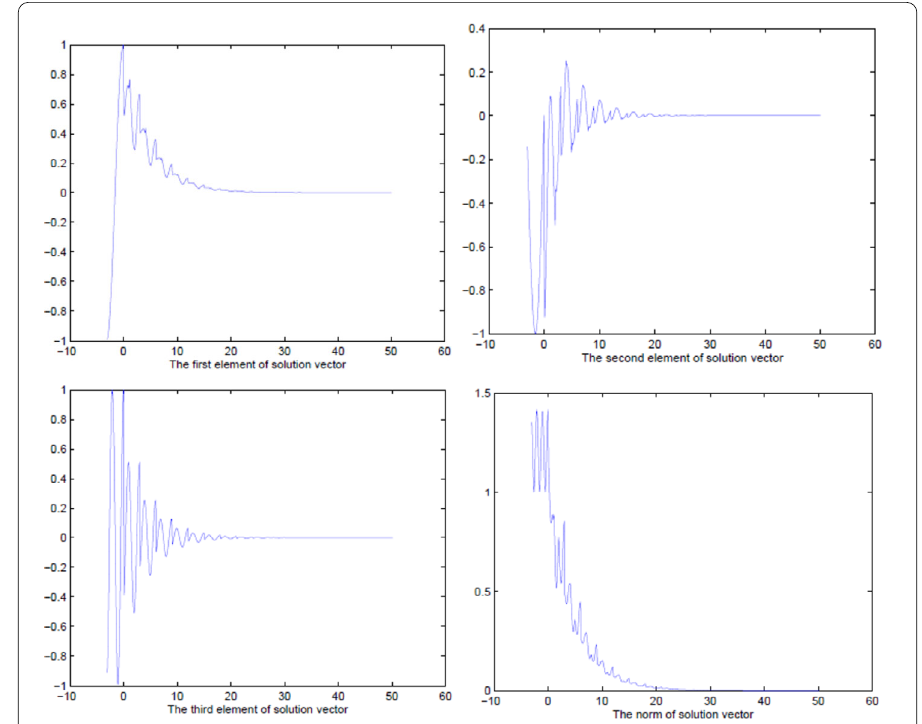
Figure 3 Numerical solutions of three components for Example